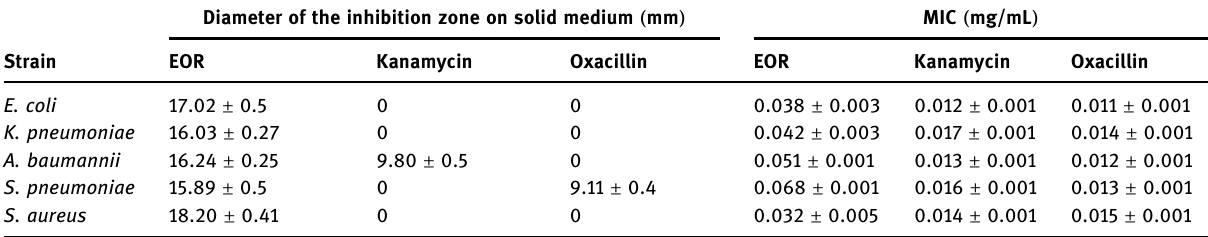
Table 3: Antibacterial activity of EOR in solid and liquid mediums Diameter of the inhibition zone on solid medium ( mm